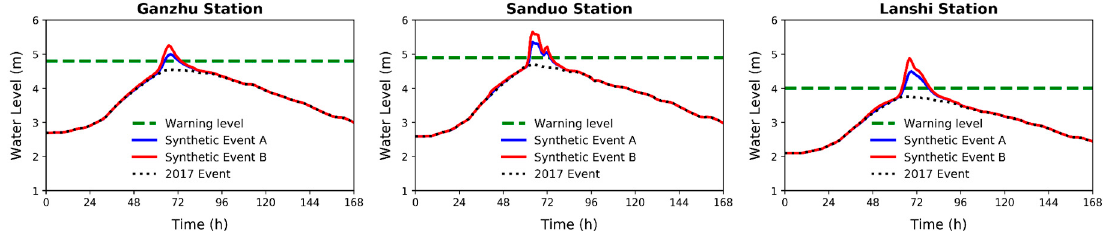
Figure 10. Comparison of the calculated water levels for Syn A and Syn B events along with the 2017 event at Ganzhu, Sanduo and Lanshi stations.